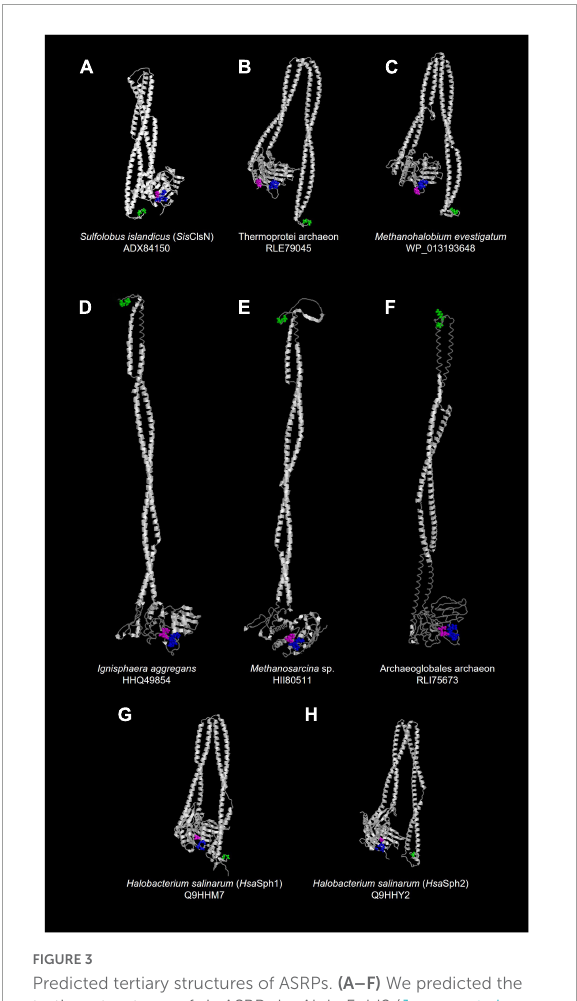
FIGURE3 Predicted tertiary structures of ASRPs. (A–F) We predicted the tertiary structures of six ASRPs by AlphaFold2 (Jumper et al., 2021). The output files in the PDB format are available as Supplementary Materials . (G,H) The predicted tertiary structures of Hsa Sph1 (Q9HHM7) and Hsa Sph2 (Q9HHY2) were visualized from the files downloaded from AlphaFold Protein Structure Database (https://alphafold.ebi.ac.uk/). The amino acid residues in the zinc hook, Walker A, and Walker B motifs are shown in a ball-and-stick representation and colored in green, blue, and magenta,